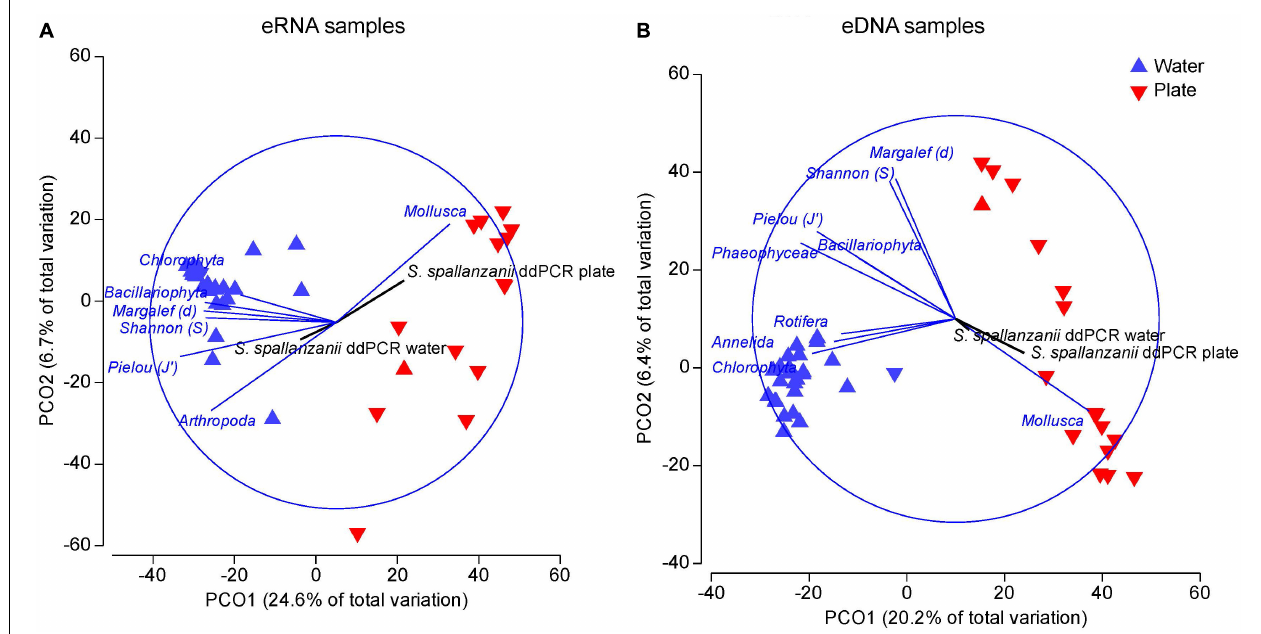
FIGURE 5 | Principal coordinate (PCO) biplots generated from rarefied data of: (A) environmental RNA samples, and (B) environmental DNA samples. Overlaid vectors show phyla and alpha diversity parameters, those significantly correlating with either of the two primary axes are displayed (Pearson correlations > 0.5). Additionally, the corresponding S. spallanzanii droplet digital PCR copy numbers for water and plate samples were overlaid as vectors (black vectors).